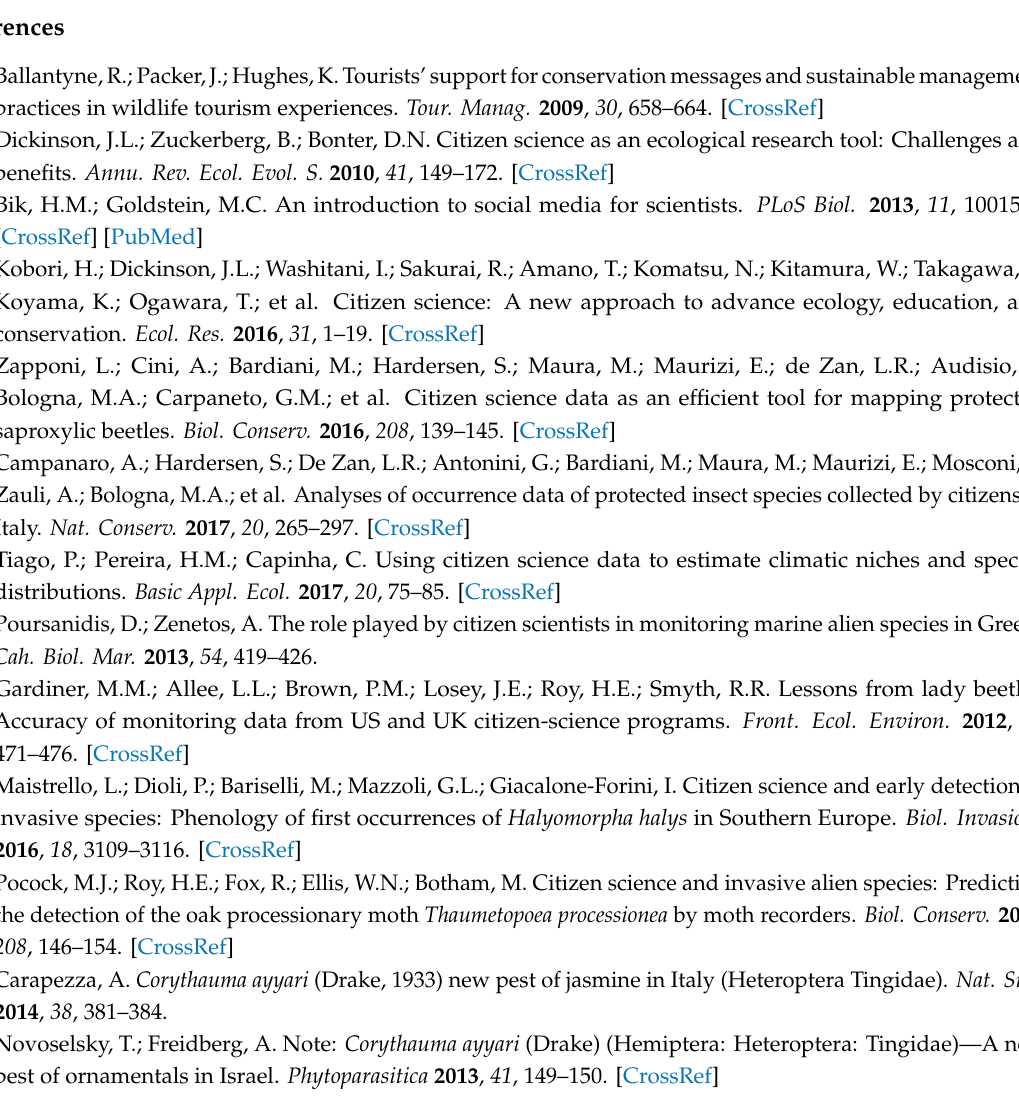
Table S1: Accession numbers of sequences used to infer the phylogenetic distances. Table S2: Occurrence of the alien tingid Corythauma ayyari in the Mediterranean basin; the year of first observation and coordinates (decimal degrees; WGS84) are indicated. Records from citizen science are